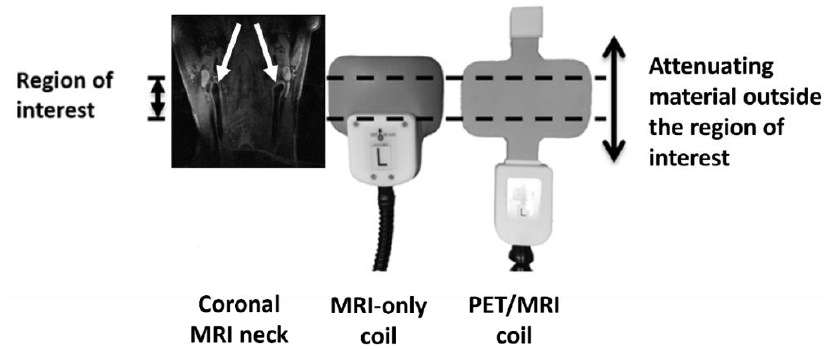
Figure 1. Adaptations to the design of the PET/MRI coil. For the dedicated PET/MRI coil, the electronic housing has been moved further away from the coil elements. The cushioning material that has been used is also thinner and less attenuating. The white arrows point to the left and right carotid